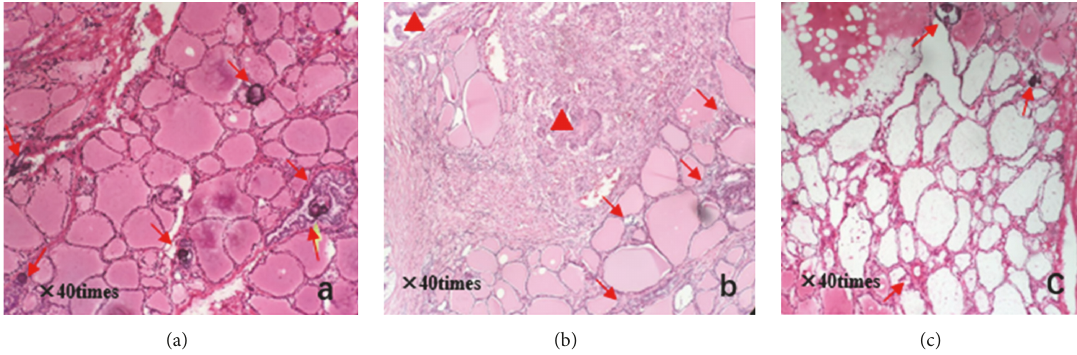
Figure 5: (a) Pathology section of right thyroid lobe: red arrow for psammoma body. (b) Pathology section of thyroid isthmus: red triangle for large carcinoma lesions; red arrow for small lesions composed of dozens of heterocyst. (c) Pathology section of left thyroid lobe: red arrow for psammoma